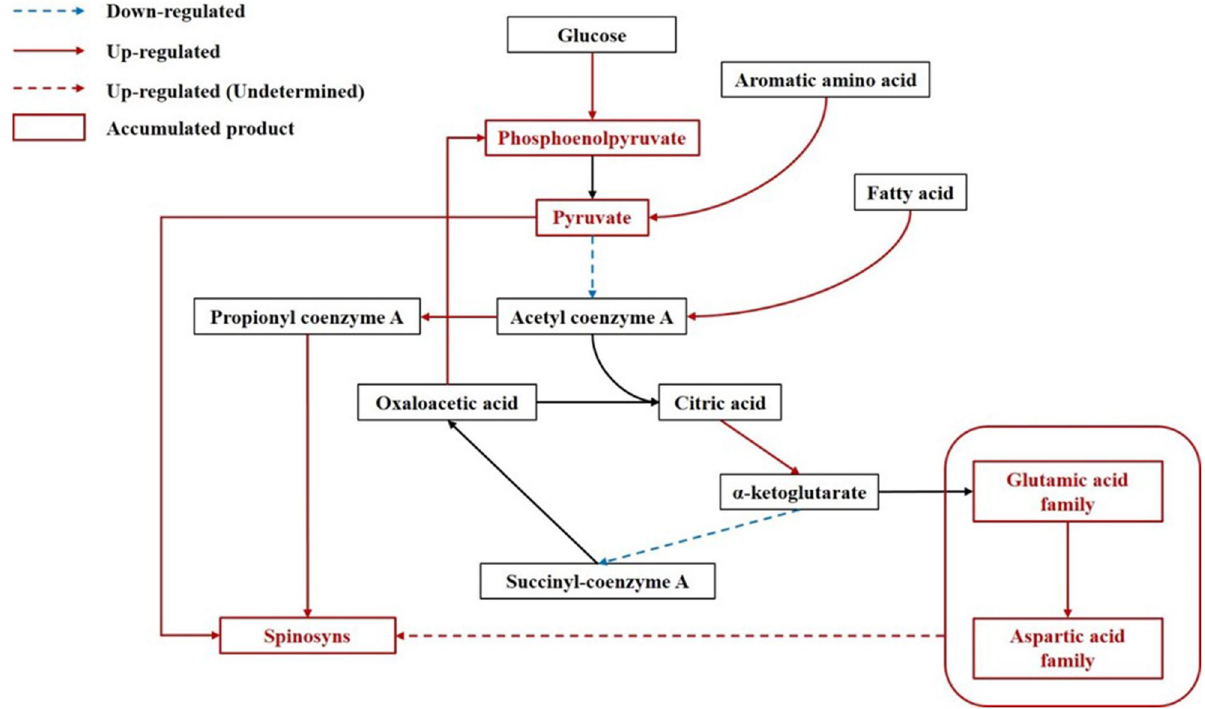
Figure 8. Schematic metabolism network between spinosad biosynthesis and primary metabolism pathways. (The chart was carried out using Microsoft Office Professional Plus